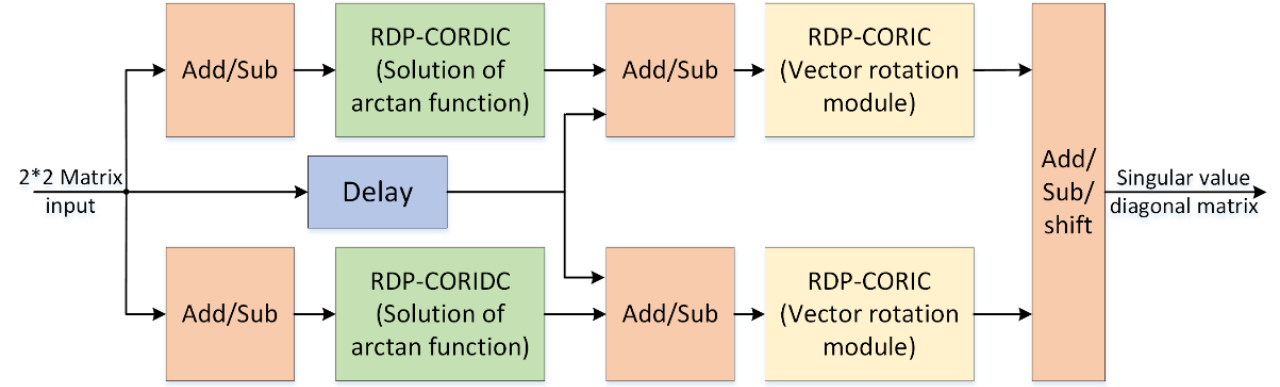
Figure 7. Structure of 2 × 2 SVD module based on RDP-CORDIC algorithm.